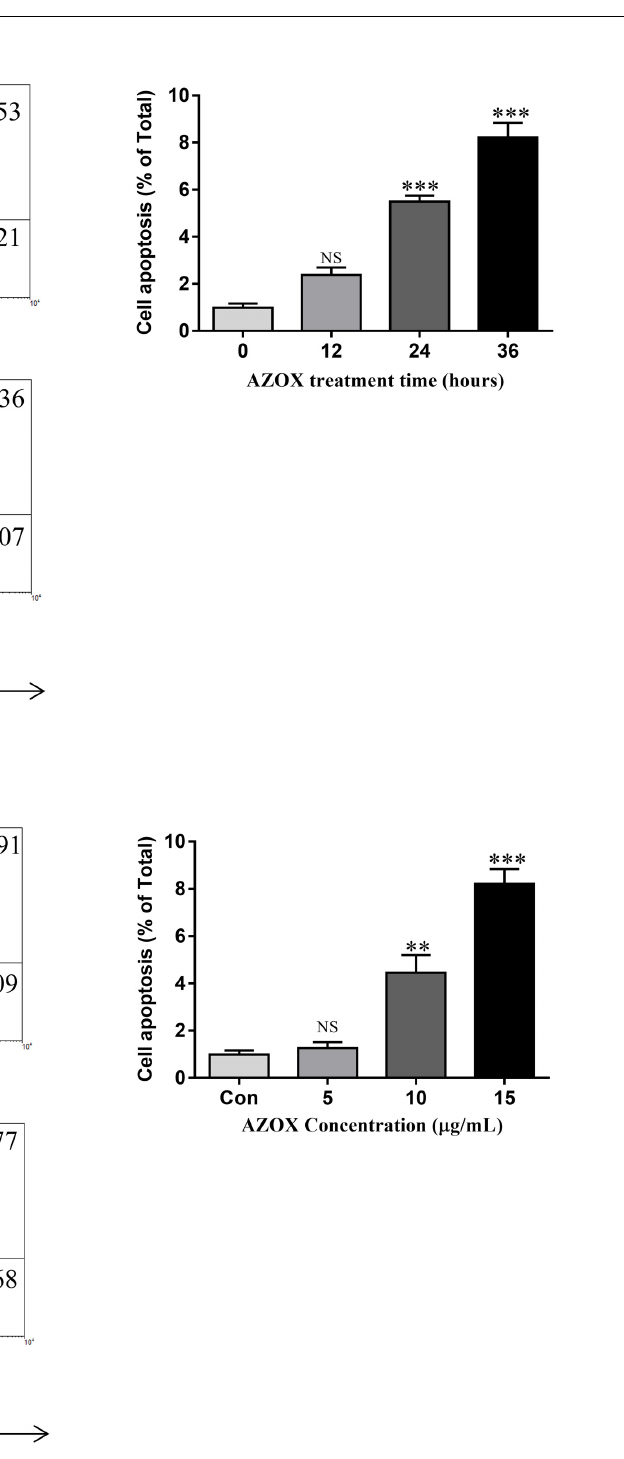
Frontiers in Pharmacology |